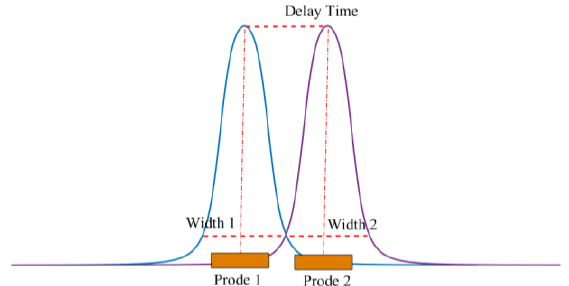
Figure 4. The two probes structure.